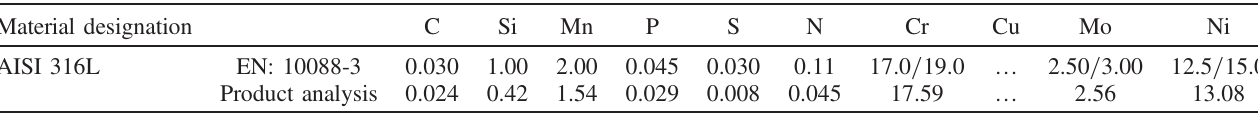
TABLE II. SS316L chemical composition [wt %] and material designation according to EN10088-3 and product analysis. Material designation